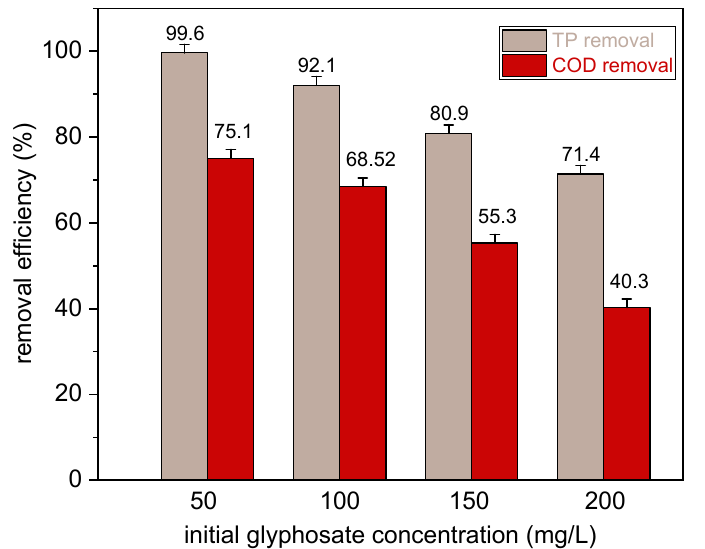
Figure 9. Effect of initial glyphosate concentration on TP and COD removal (Condition: pH, 3.0; the initial nCPs dosage, 0.2 g; Ca 2+ /Fe 2+ molar ratio, 6; contact time, 75 min; RT; 150 rpm).